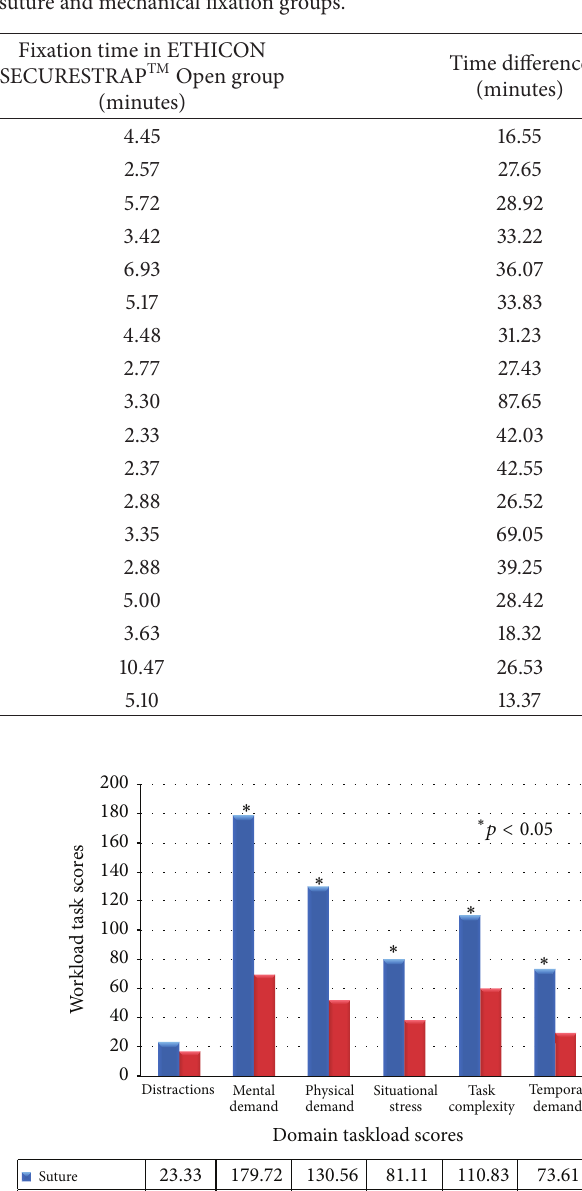
Table 1: Fixation time difference between suture and mechanical fixation groups.